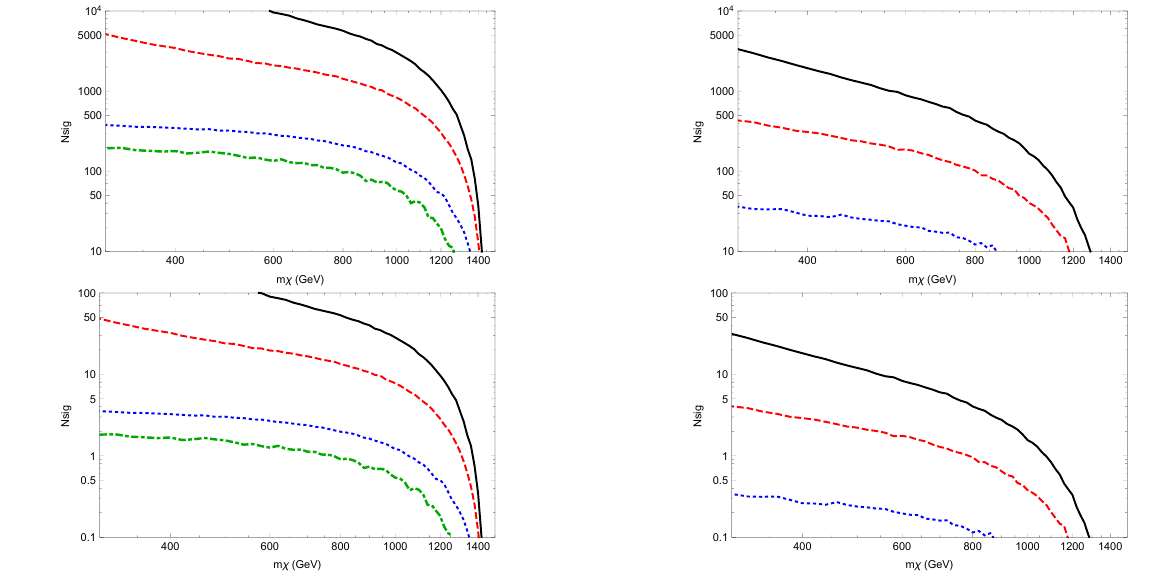
Figure 7 . Number of double-disappearing-track events expected in our models as a function of mass. The left (right) side shows fermion (scalar) models. The upper row assumes 100% e(cid:14)ciency for photon and disappearing track reconstruction; the lower row assumes the energy-dependent photon e(cid:14)ciency and 10% for disappearing tracks. The di(cid:11)erent lines label models with the same convention as (cid:12)gure